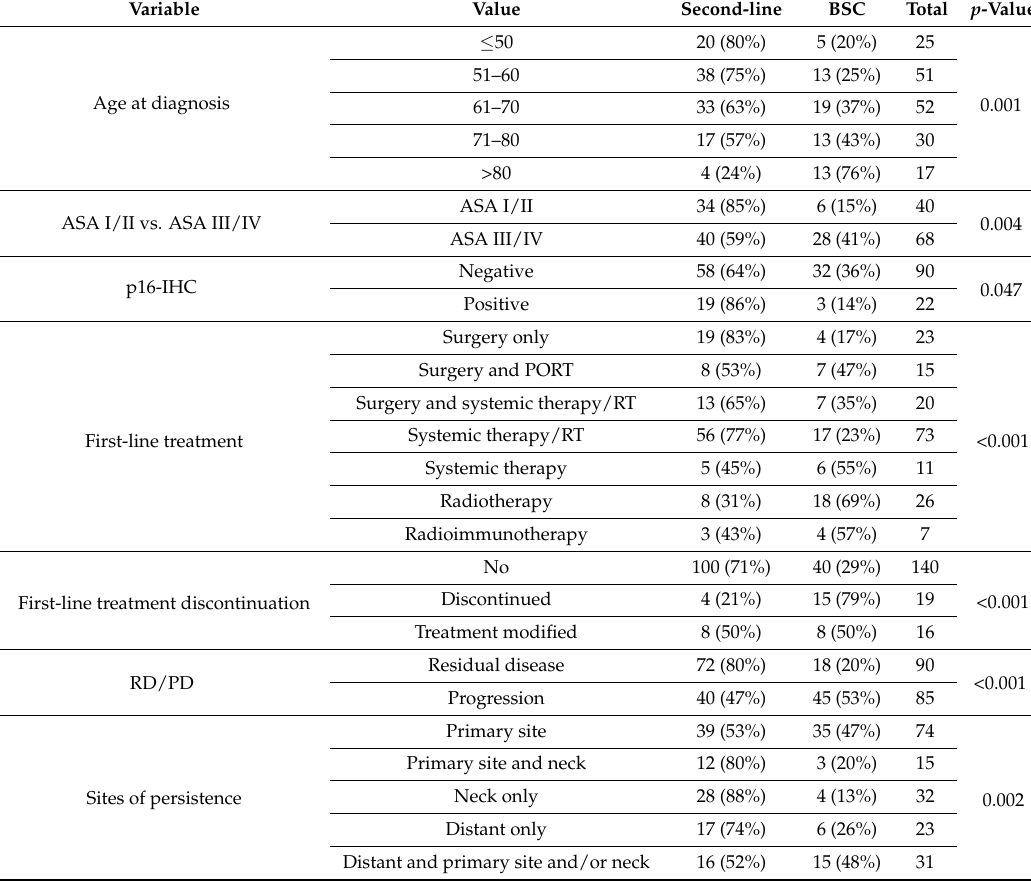
Table 3. Patients and disease factors (left column) and frequencies of BSC vs. any second-line antineoplastic treatment in patients with persistent HNC after first-line therapy. In brackets, row percent for each factor value are presented. Only factors with unequal frequency distribution (Chi-square p < 0.05; right column) are tabulated. Sex, tumor site, and initial clinical union internationale contre le cancer (UICC) stage did not significantly influence whether patients received BSC or second-line treatment. All treatments were based on the advice of the interdisciplinary tumor